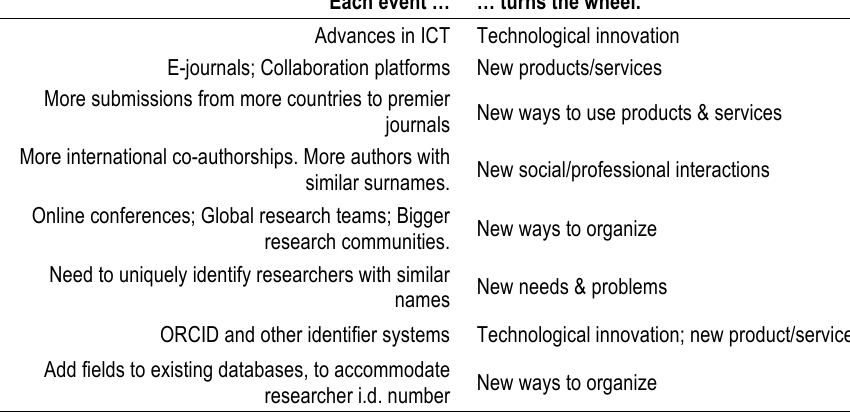
Table 3. Example: Individual researcher i.d.’s and the Circle of Innovation Each event … … turns the